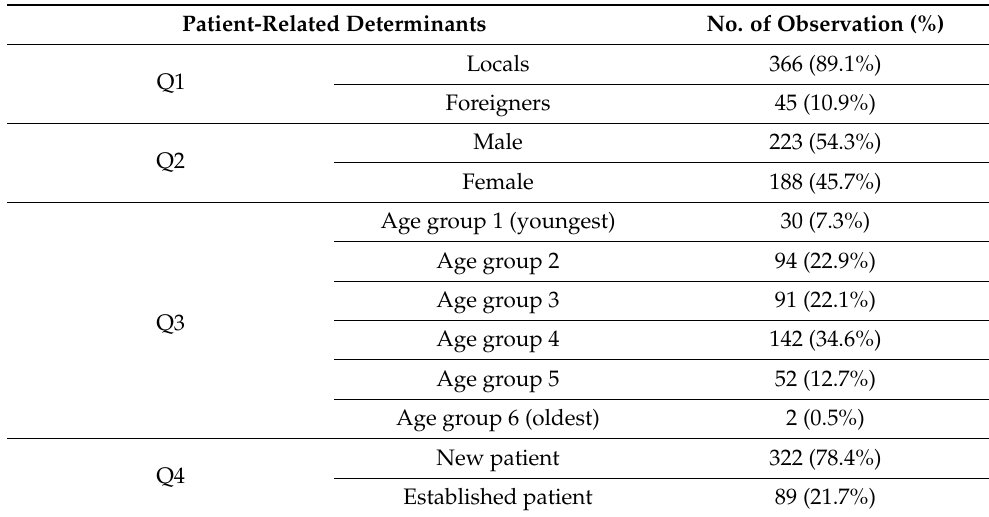
Table 5. Patient-related